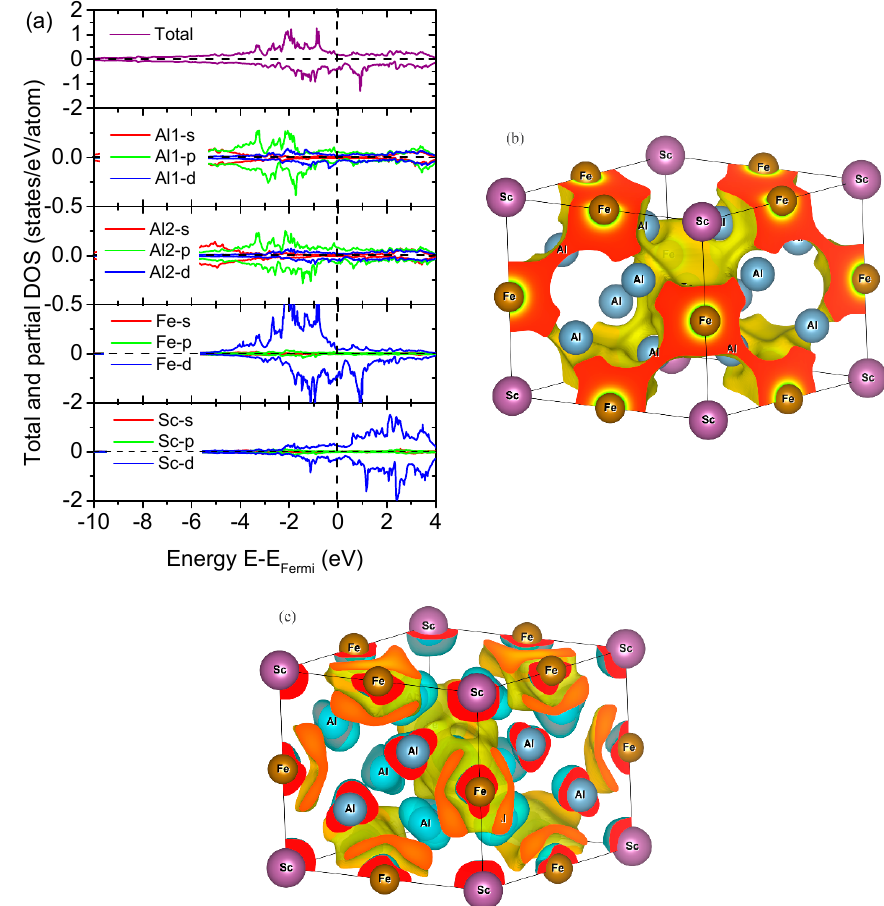
Figure 3. ( a ) The total and partial density of states, ( b ) electron localization function, and ( c ) bonding charge density of Al 8 Fe 4 Sc.